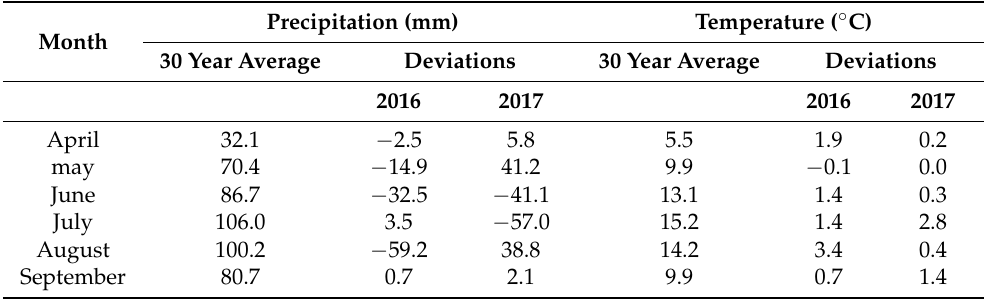
Table 1. Long-term average monthly precipitation and temperature (1986–2015) and deviations during the 2016 and 2017 growing seasons of experimentation at Huangzhong, Qinghai Province. Precipitation (mm) Temperature ( ◦ Month